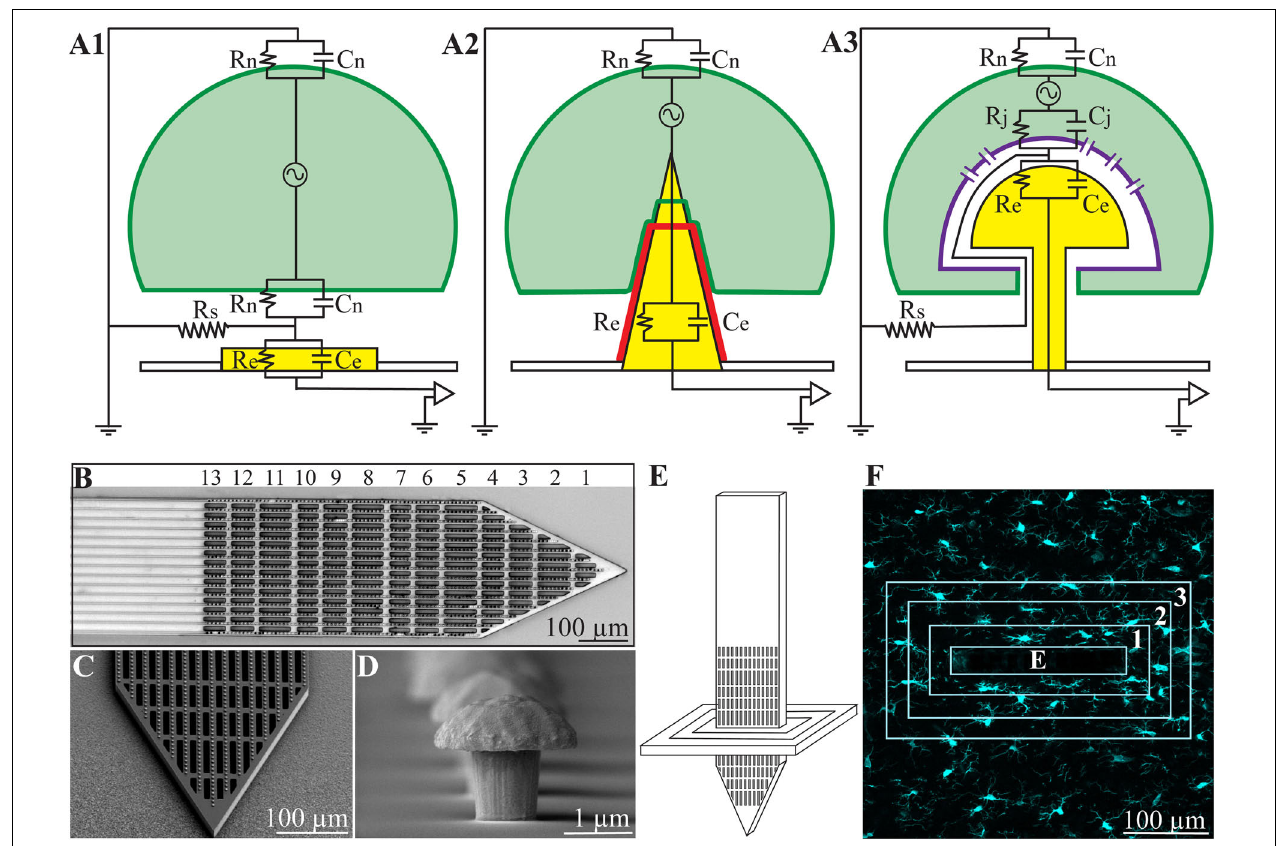
FIGURE 1 | (A) Passive analog electrical circuit models depicting the structural interfaces formed between cells and recording microelectrodes under in vitro conditions. (A1) Substrate integrated planar electrode for extracellular field potential recordings, (A2) a vertical nano-pillar electrode that pierces the plasma membrane for intracellular recordings, and (A3) extracellular gold mushroom shaped vertical microelectrode (gM µ E) for IN-CELL recordings. The three configurations differ mainly in terms of the nature and dimensions of the cleft formed between the cultured cells (neurons, cardiomyocytes, or striated muscle fibers) and the recording electrode. In panel (A1) , the extracellular field potential generated by propagating action potentials is largely attenuated across the high resistance non-junctional membrane (Rn) and the low seal resistance (Rs). In panel (A2) , the vertical nanoelectrode pierces the cell’s plasma membrane, gaining direct access to the cytosol (Rn is reduced to zero). A very high seal ( ∼ G (cid:127) ) resistance (not drawn) formed between the vertical nanoelectrode’s (yellow electrode with a red insulating layer) surface and the plasma membrane (green). In panel (A3) , the cell engulfs a mushroom shaped vertical electrode (yellow) to form relatively high Rs by the narrow cleft. Along with reduced junctional membrane resistance (Rj -purple) the configuration makes it possible to record attenuated intracellular potentials. (B) Low magnification image of the polyimide based perforated MEA platform (PPMP), the proximal solid part and distal perforated part are shown. For orientation, the rows of perforations are numbered. (C) SEM enlargement of a PPMP segment, showing the perforations of the polyimide platform and dense rows of gM µ Es along the PI “ribs.” (D) A SEM image of a gM µ E. (E) Schematic illustration of an implanted PPMP and the orientation of thick horizontal tissue slices. (F) The integrated immuno-fluorescent intensity within the electrode (central rectangle-E) and within 25 µ m wide centripetal shells around it were measured and processed to establish the Normalized Fluorescent Intensity level (NFI) or the number of a given cell type at a given distance and time around the